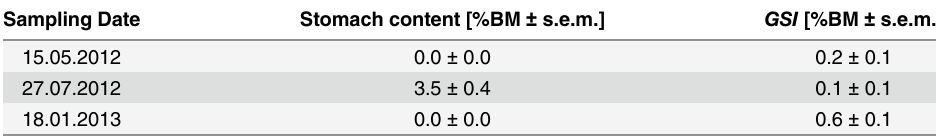
Table 1. Stomach content in % of body mass (BM), and gonadosomatic index ( GSI ) in % of BM of anadromous Arctic charr ( n = 10) sampled during study. Sampling